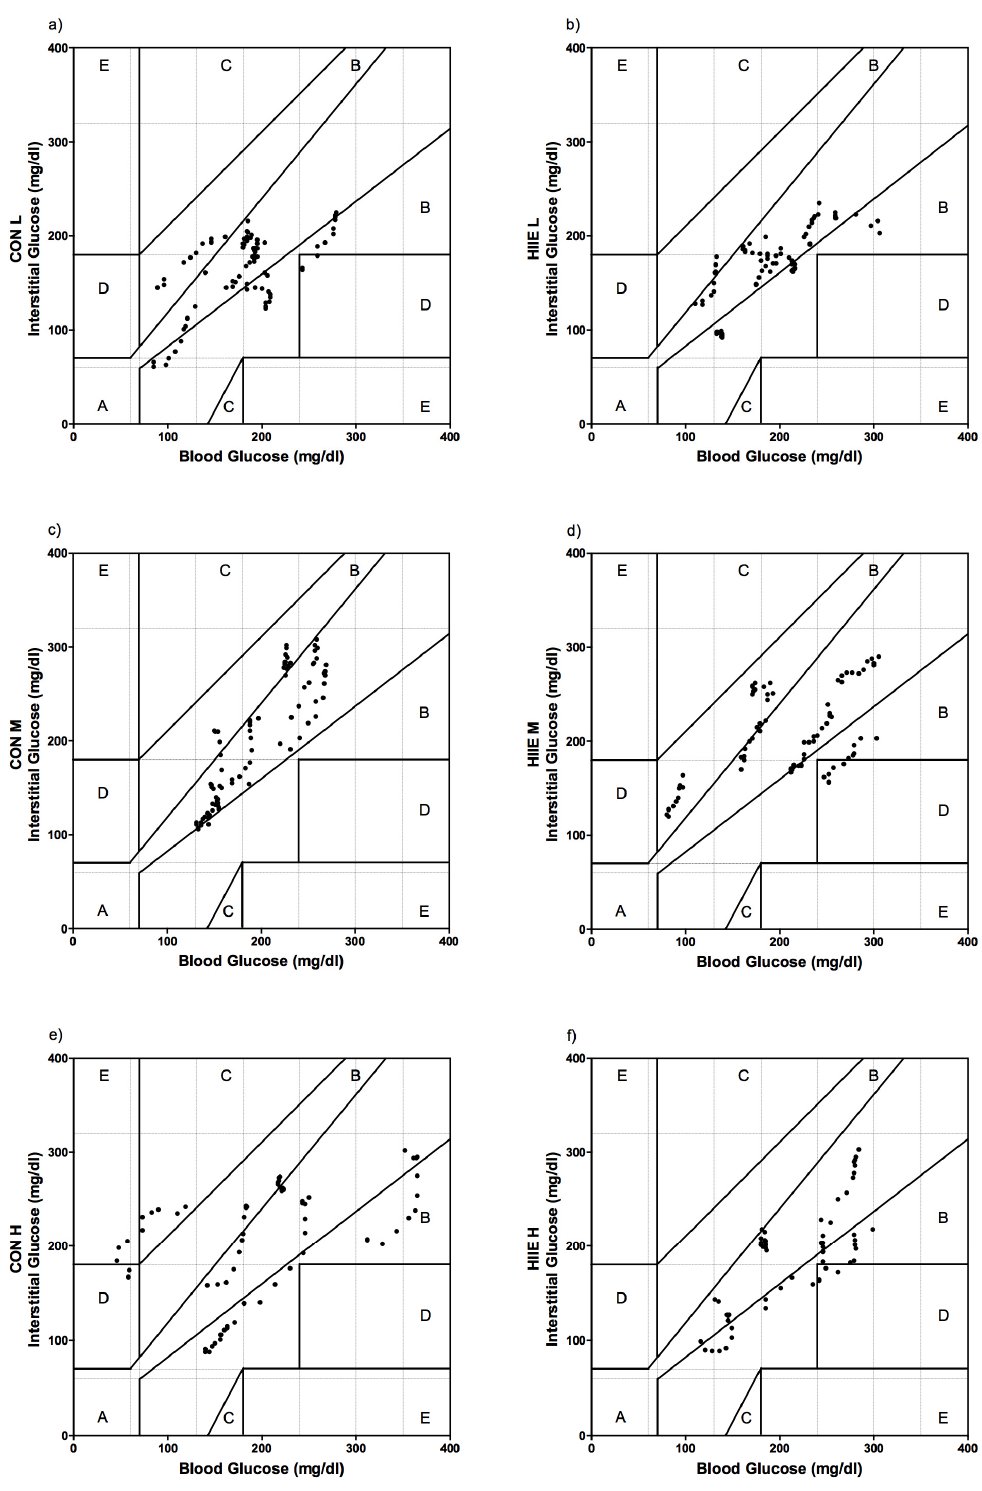
Figure 6. The Clarke Error Grid analyses given for the three standardized exercise intensities. CON for exercise intensities L ( a ), M ( c ), and H ( e ); as well as HIIE for exercise intensities L ( b ), M ( d ), and H ( f ).